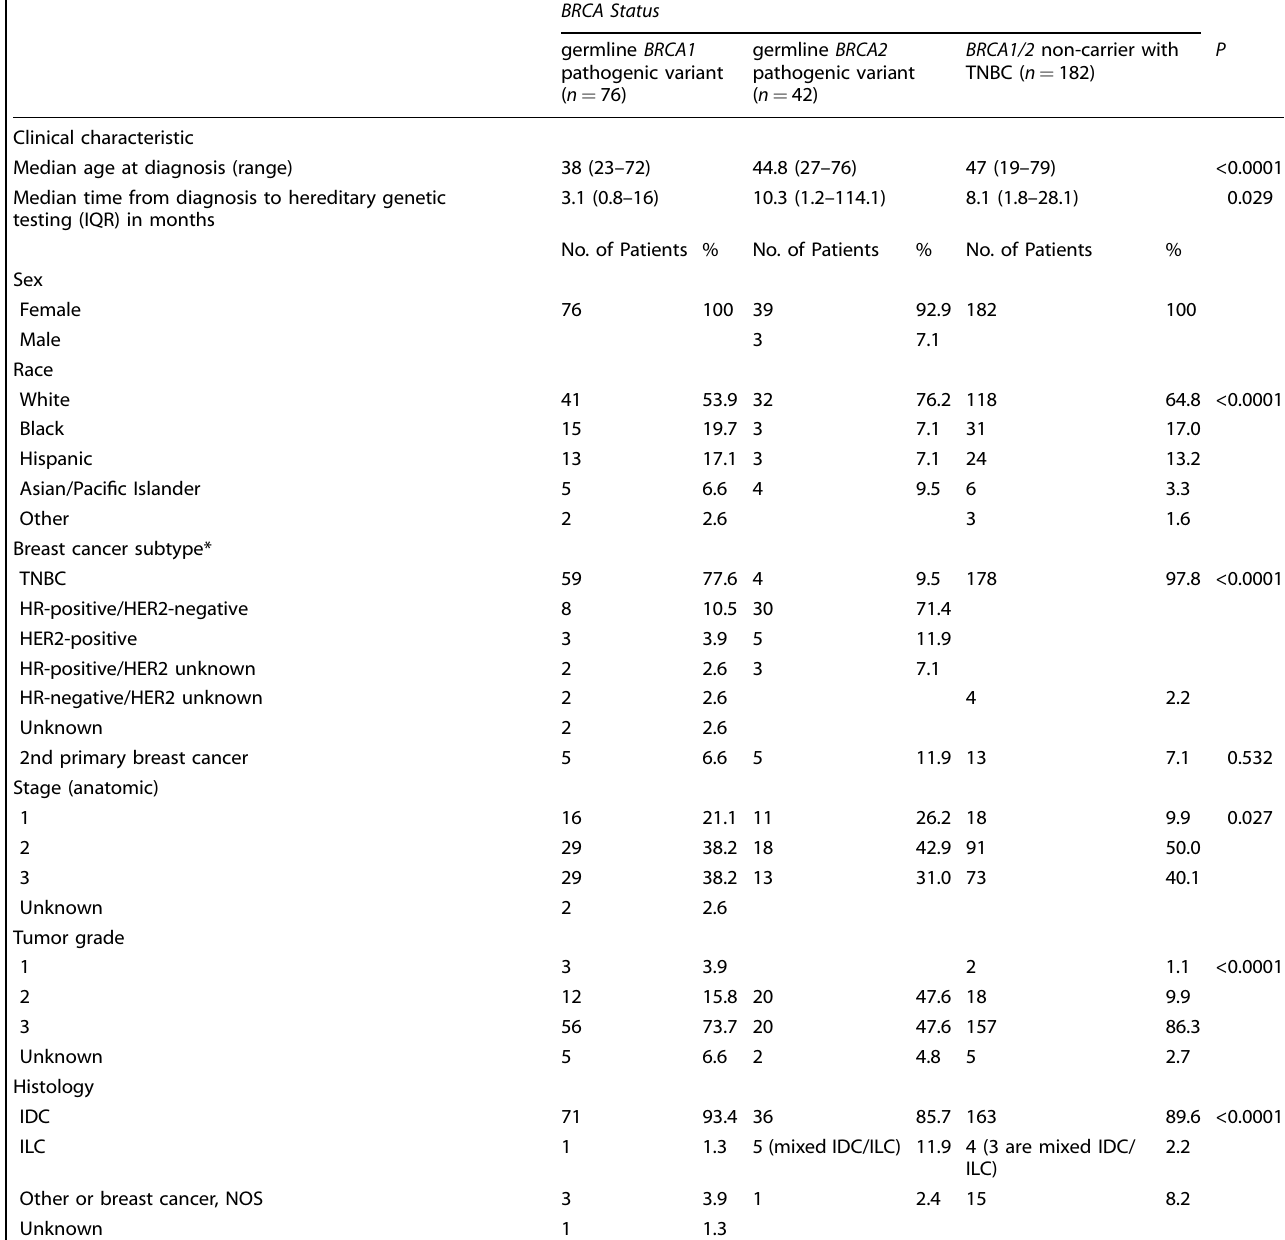
Table 1. Clinical characteristics of patients with distantly recurrent breast cancer by germline BRCA